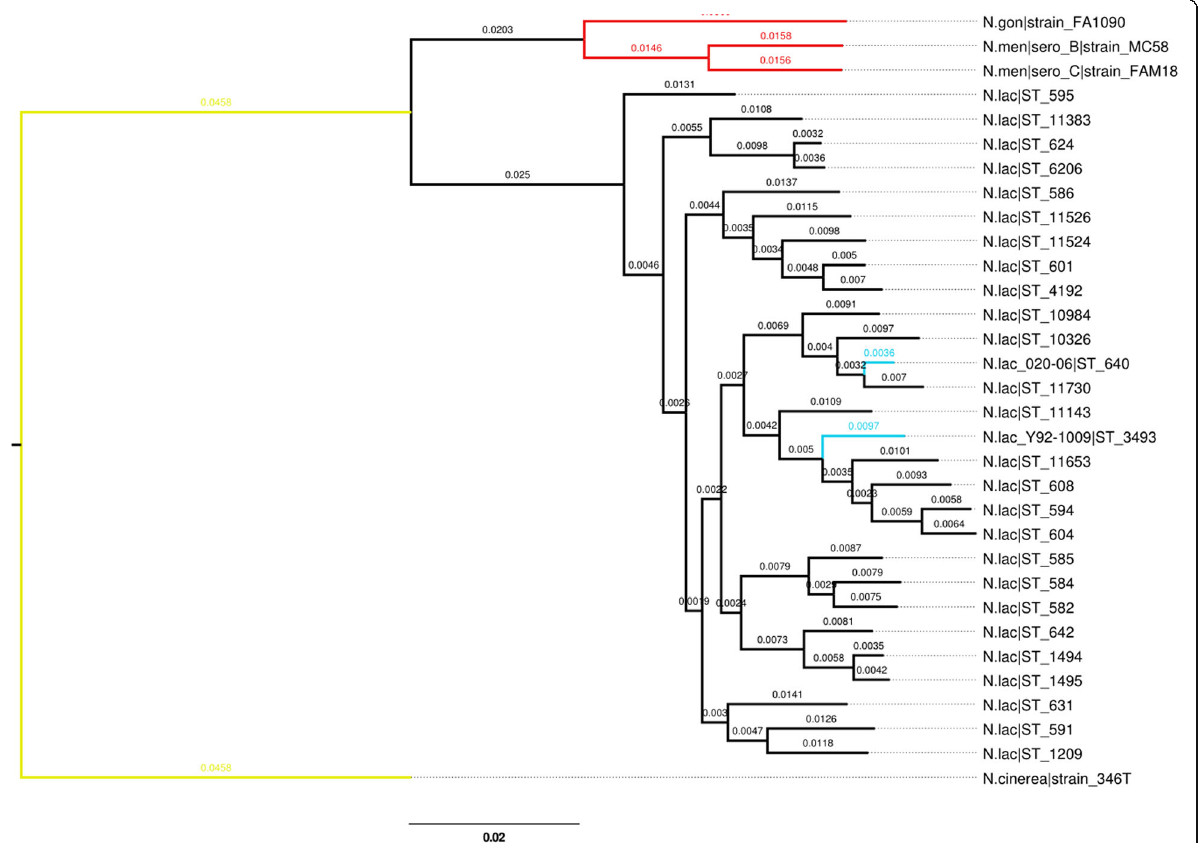
Fig. 2 Phylogenetic tree indicating the position of N. lactamica Y92 – 1009 amongst other pathogenic and commensal Neisseria . This tree was constructed based on a core genome comparison of a collection of 32 Neisseria assemblies generated using the genome comparator tool available on pubmlst.org/neisseria. The reconstructed evolutionary relationships among N. meningitidis ( Red , n = 2), N. gonnorhoeae ( Red , n = 1), N. cinerea ( Yellow , n = 1) and N. lactamica ( Black , n = 27) are shown. The genome sequenced here, N. lactamica Y92 – 1009 is outlined in cyan (Nla_PacBio|ST_3493). This analysis included the sequenced genome and the best representative assembly for every identified sequence type (ST) of this species. The tree was generated using FastTree v.2 [13] and edited using Figtree v.1.4.3 [14]. The tree is drawn to scale, with branch length units being expressed as an overall proportion of divergence based on the comparison of 1629